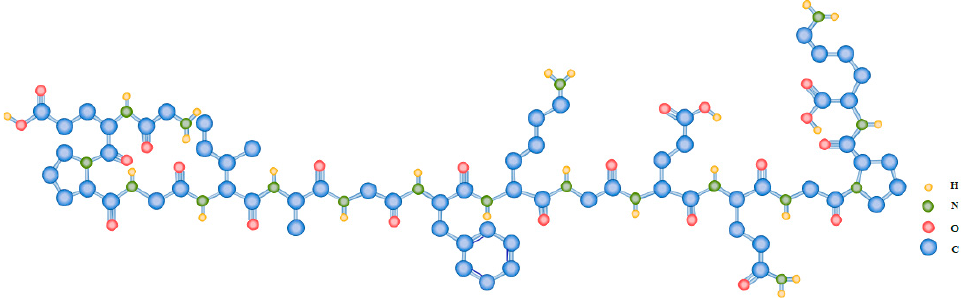
Figure 2. Exemplary amino acid repetition of the triplet (Gly ‐ X ‐ Y)n characteristic of type I